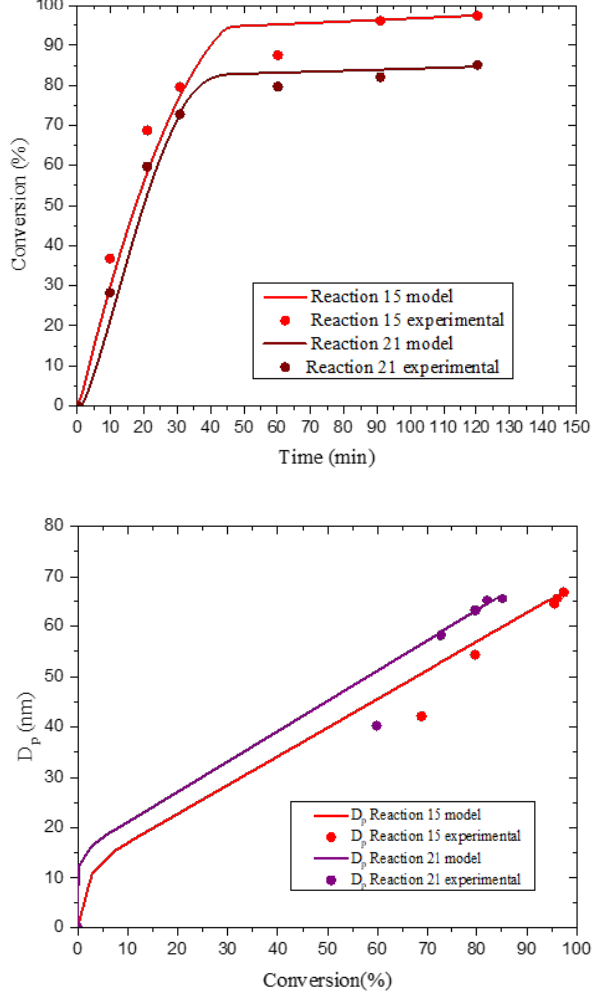
Figure 7. Comparison of simulation (POLYRED) and experimental data for monomer conversion vs. reaction time ( top ) and D p vs. monomer conversion ( bottom ) for experiments E15 and E21.